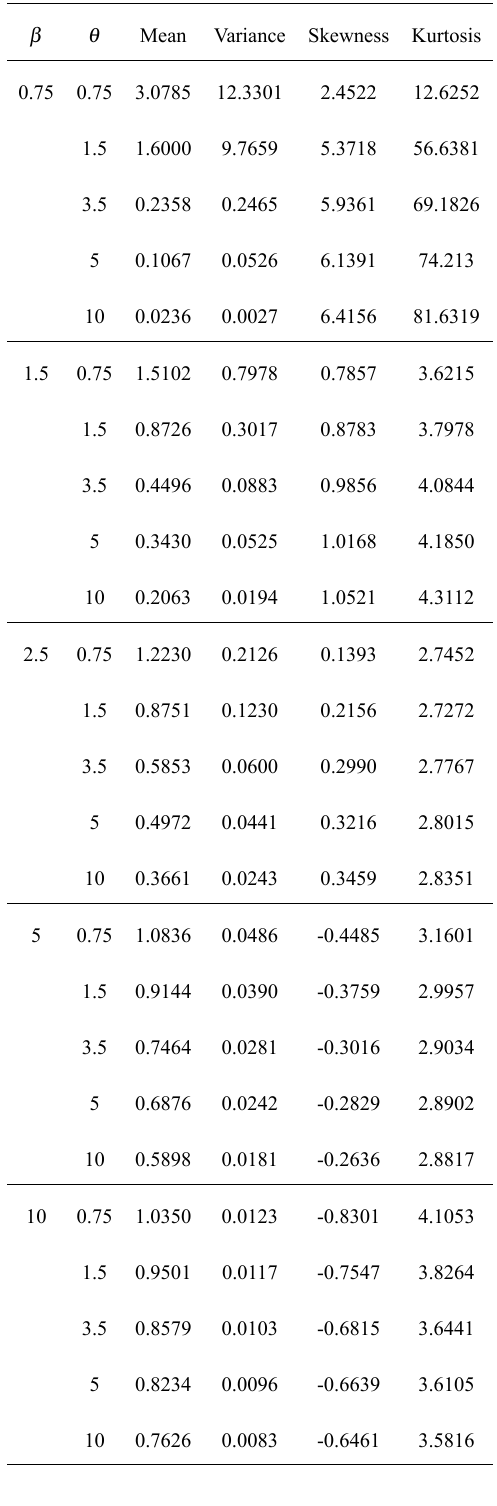
Mean, variance, skewness and kurtosis of the LiW distribution for α = 1 and different values of β and θ